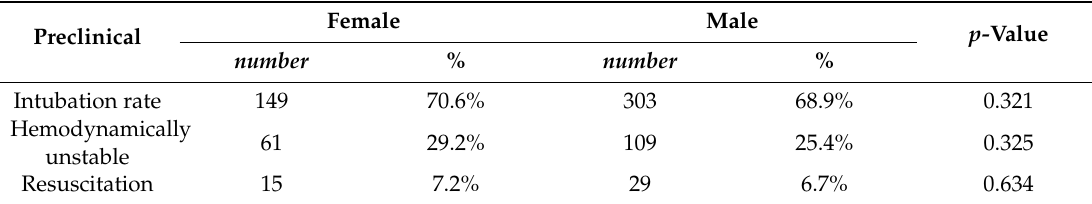
Table 2. Preclinical Data.